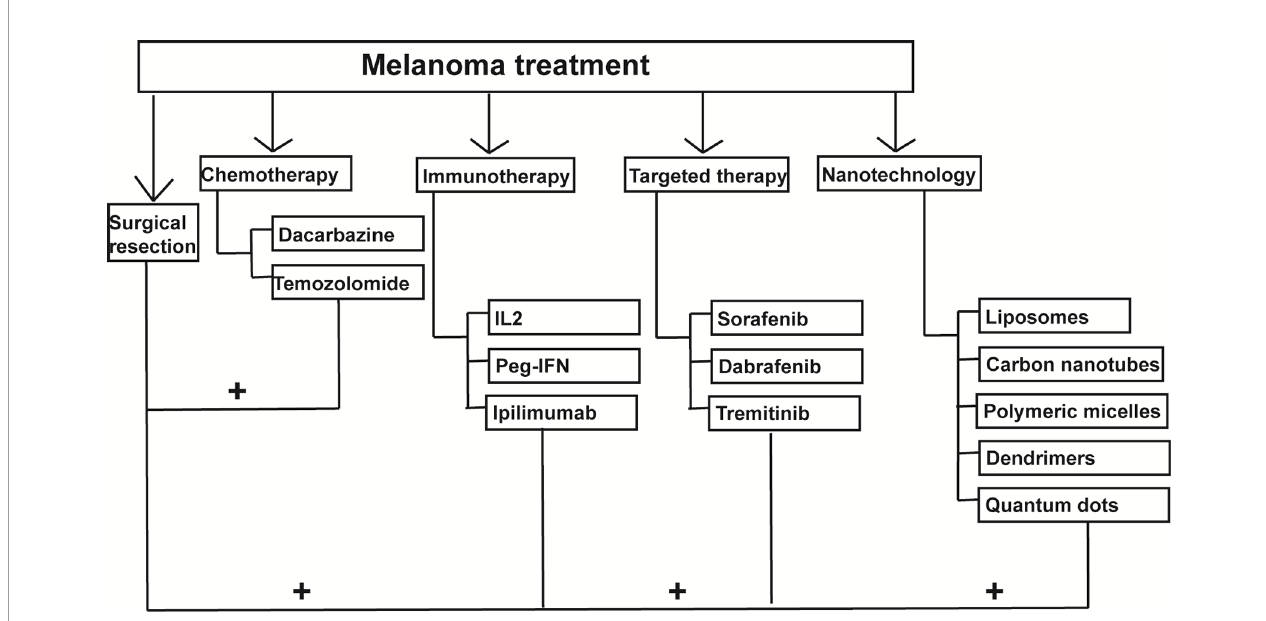
FIGURE 2 | Nanoparticles-mediated combination therapies for melanoma treatment. Nanoparticles can be combined with chemotherapy, immunotherapy and photodynamic therapy to treat